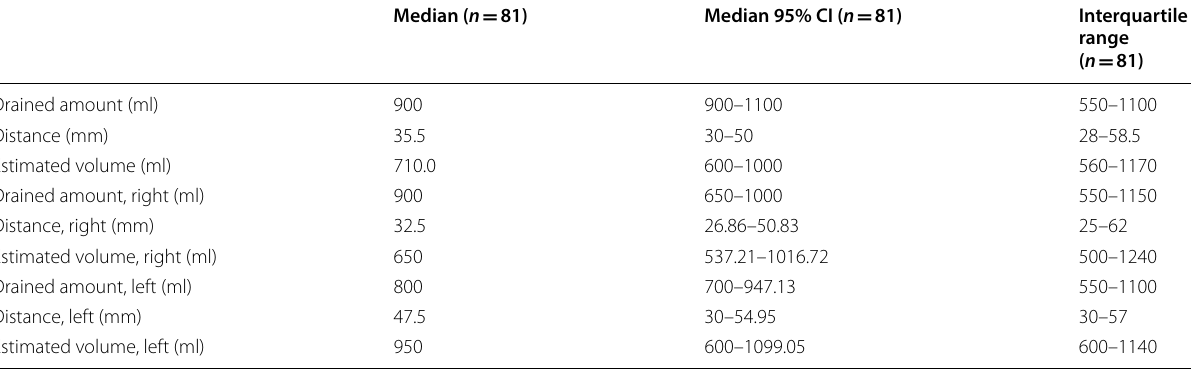
Table 4 Amount of drainage in milliliters (ml), interpleural distance prior to procedure in millimeters (mm), volume estimated using Balik’s